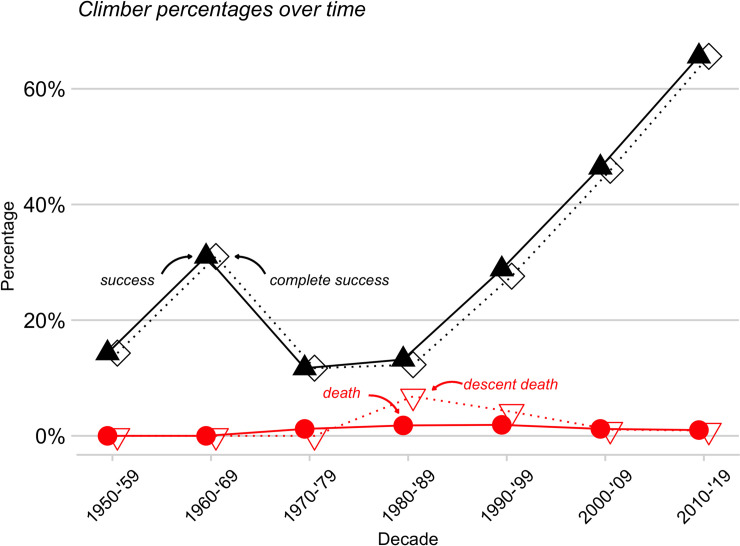
Rates of success (summited), complete success (summited and survived), overall death, and death descending from the summit.Rates are dodged to facilitate comparisons.